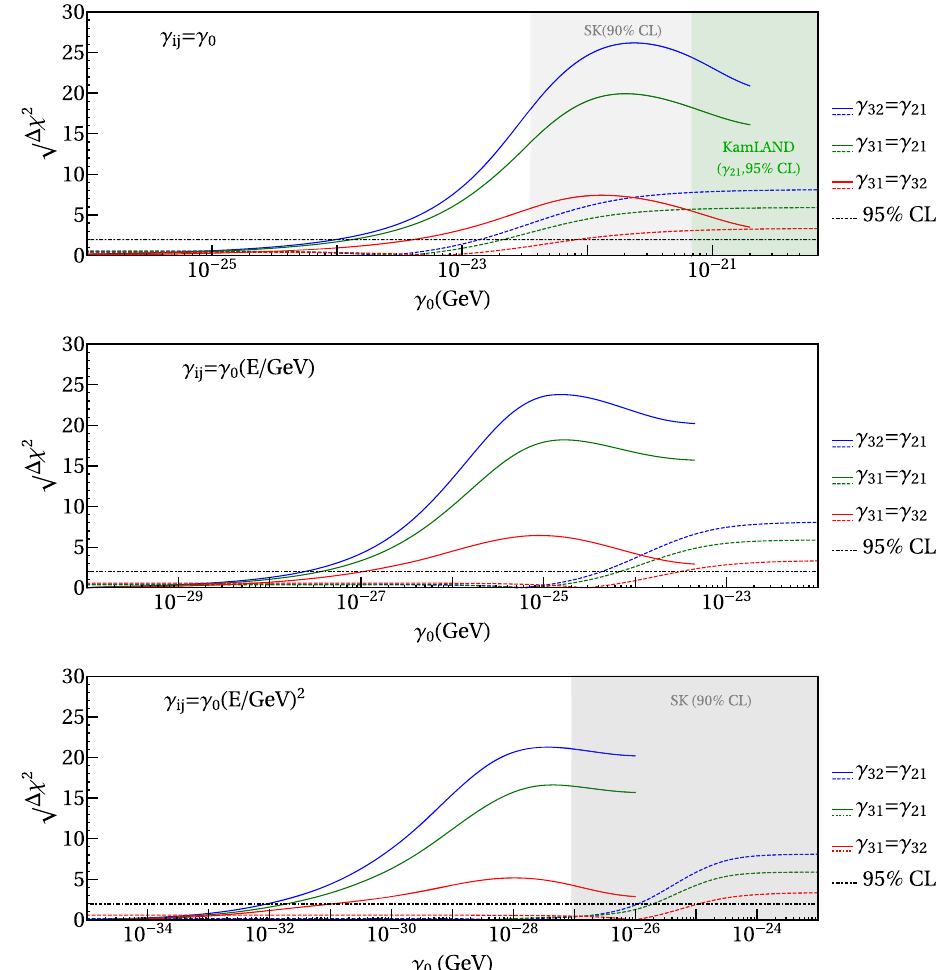
(cid:14) Δχ 2 as a function of the decoherence parameter Fig. 5 Values of the for the Atmospheric limit (red), Solar limit I (green) and Solar limit II (blue) defined in Sect. 3. The results obtained from our analysis of Ice- Cube(DeepCore)dataaredenotedbythesolid(dashed)lines.Thethree panels have been obtained for NO, assuming a different dependence on